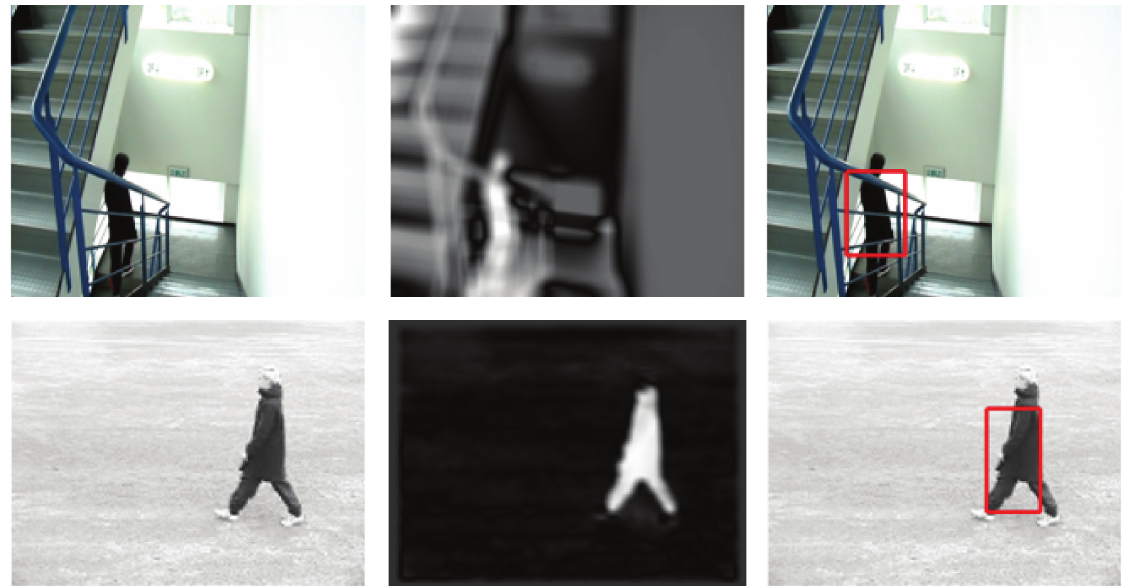
Figure 14: Videos (1) and (2): results of modified frequency tuned spatial model II.